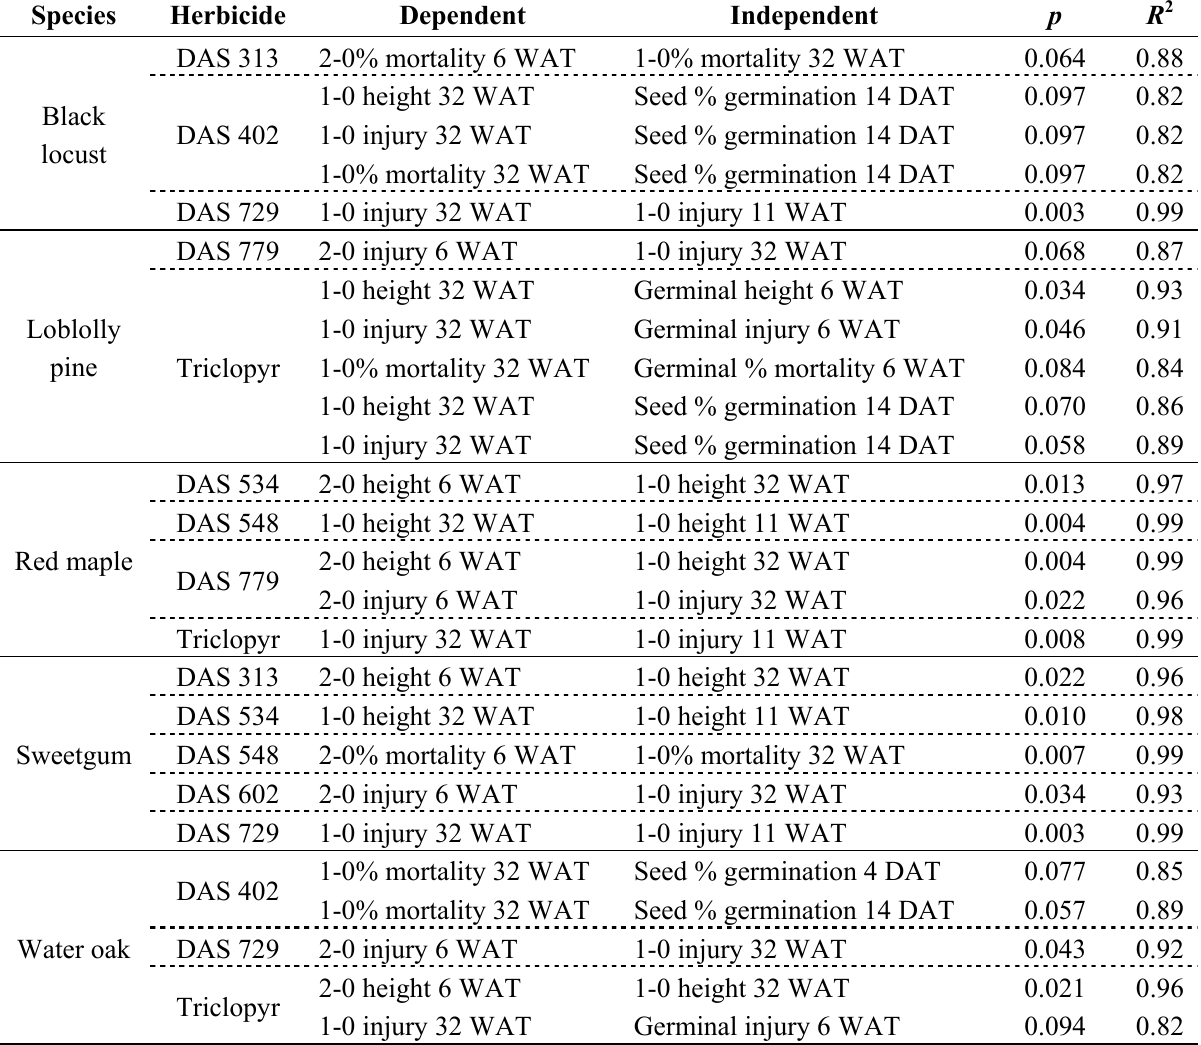
Table 5. Summary table for best significant linear regression models predicting greenhouse seedling responses using rapid screening data †